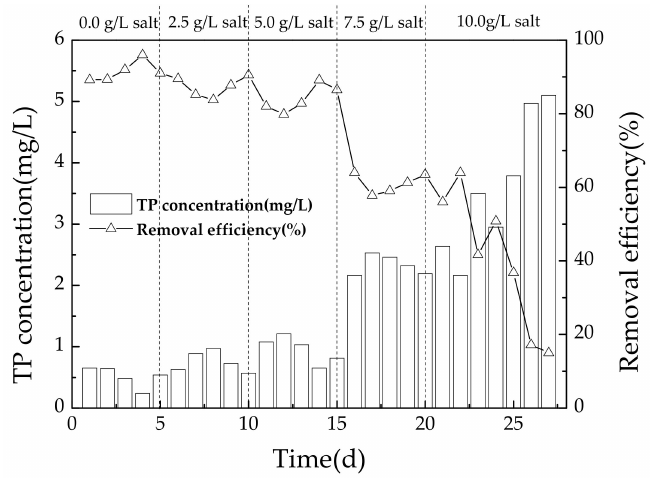
Figure 5. Removal of TP at varying salinity.